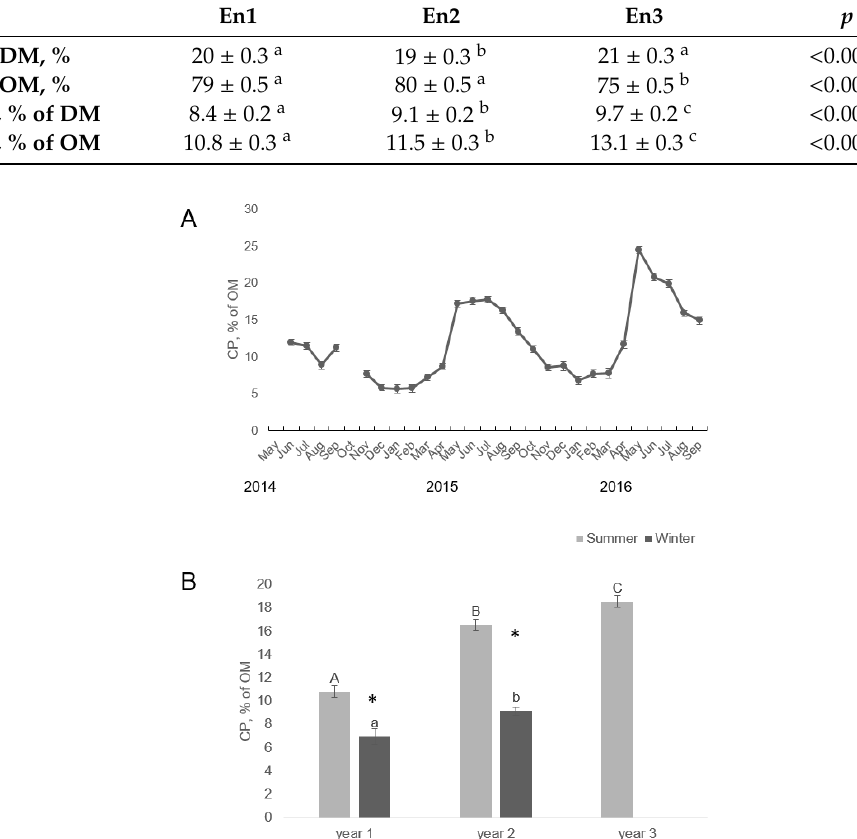
Figure 3. ( A ) Monthly variation and ( B ) seasonal and between-year variation in crude protein (CP) content (LSmeans ± SE) as % of organic matter (OM) in feces from Gotlandsruss grazing without supplementary feeding from May 2014 to September 2016. One year is defined as start of summer season to end of winter season.